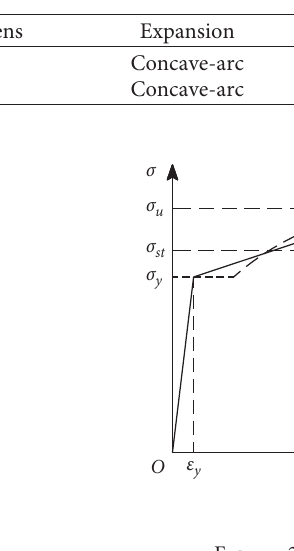
Figure 1: Details of specimens. (a) WF-1. (b) Finite element Table 1: Specimen parameters.